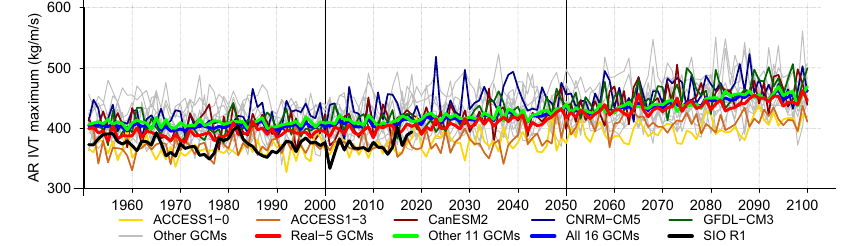
Figure 1. Annual average maximum IVT for AR events landfalling upon the West Coast [20–60°N] in historical (1951–2005, left) and projected (2006–2100, right) epochs. Real-5 GCMs are plotted in thin colored lines, while other GCMs are outlined in gray. Thick curves represent the ensemble averages of the Real-5 GCMs (red), the other 11 GCMs (green), and the full ensemble of 16 GCMs (blue). The thick black curve shows the observed (SIO-R1)